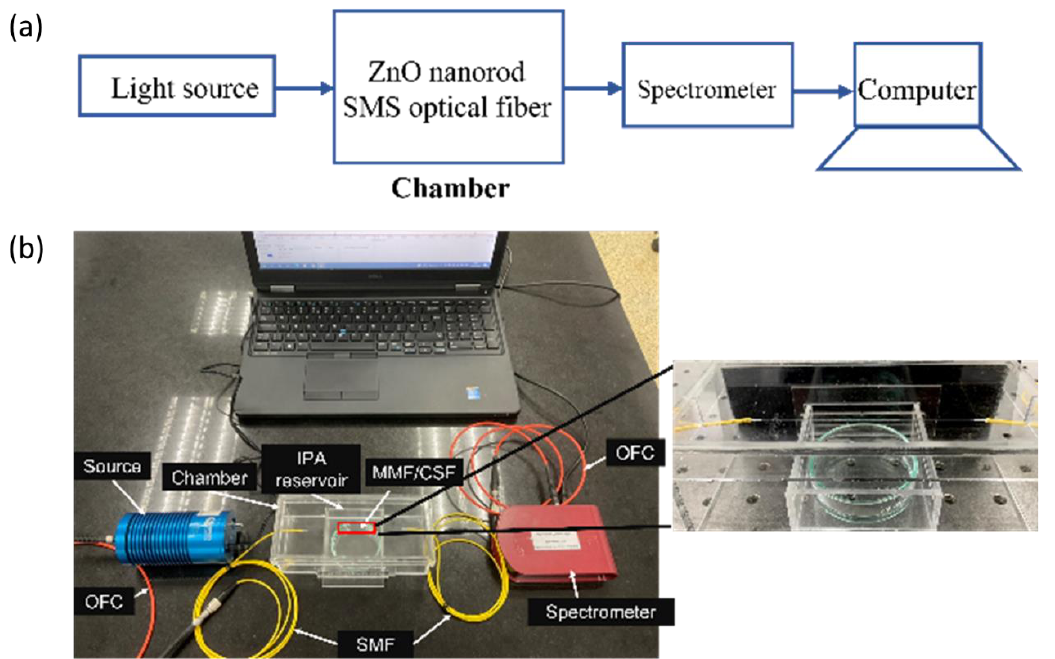
Figure 5. ( a ) Schematic representation of the experimental setup for characterizing the fabricated sensor; ( b ) actual image of an experimental setup.